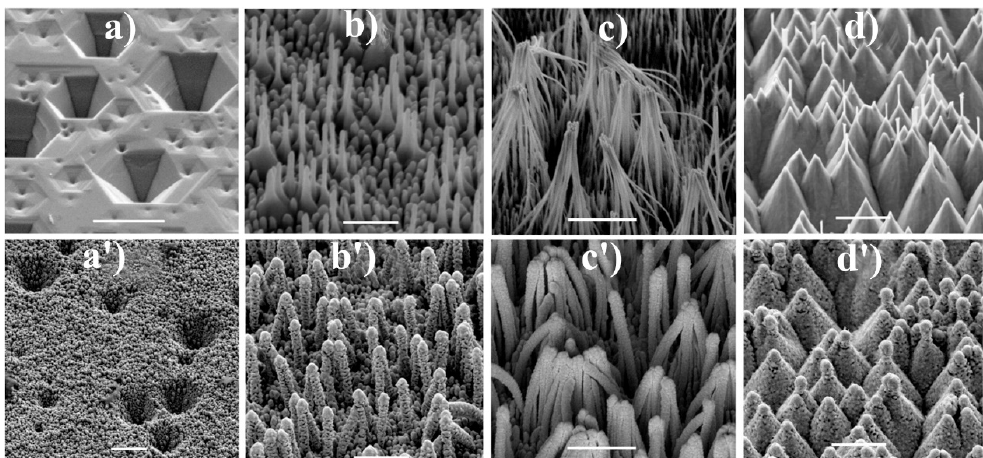
Figure 4. SEM images of GaN samples after: ( a ) orthodox etching at 420 °C for 10 min, ( b , c ) galvanic photo-etching for 8 and 12 min, respectively, ( d ) electroless photoetching for 120 min. ( a’ , b’ , c’ , d’ ) shows SEM images of similar samples after sputtering of an Au-Ag alloy. The samples are tilted 45°. The scale bars represent 1 μ m. Reprinted with permission from [37]. Copyright 2018 Elsevier.